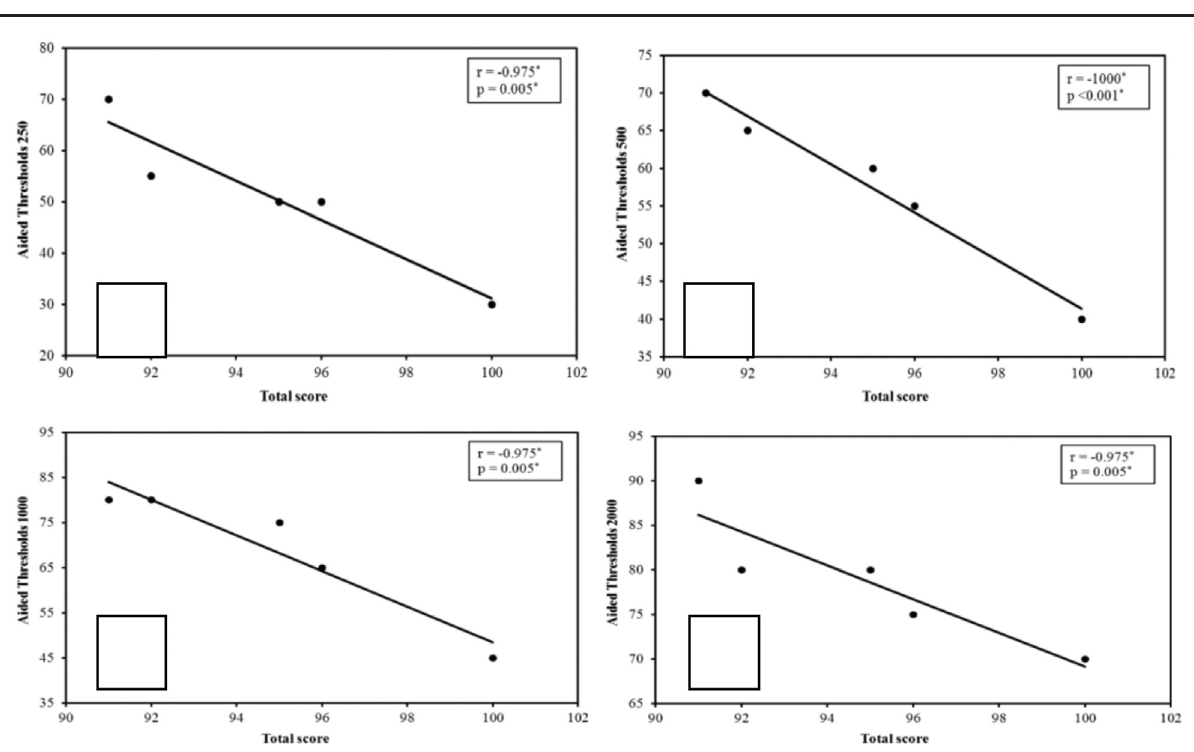
Correlation between total vowel identification test scores and preoperative hearing aided thresholds in prelingual subjects of enlarged vestibular aqueduct group at (a) 250Hz, (b) 500Hz, (c) 1000Hz, and (d)